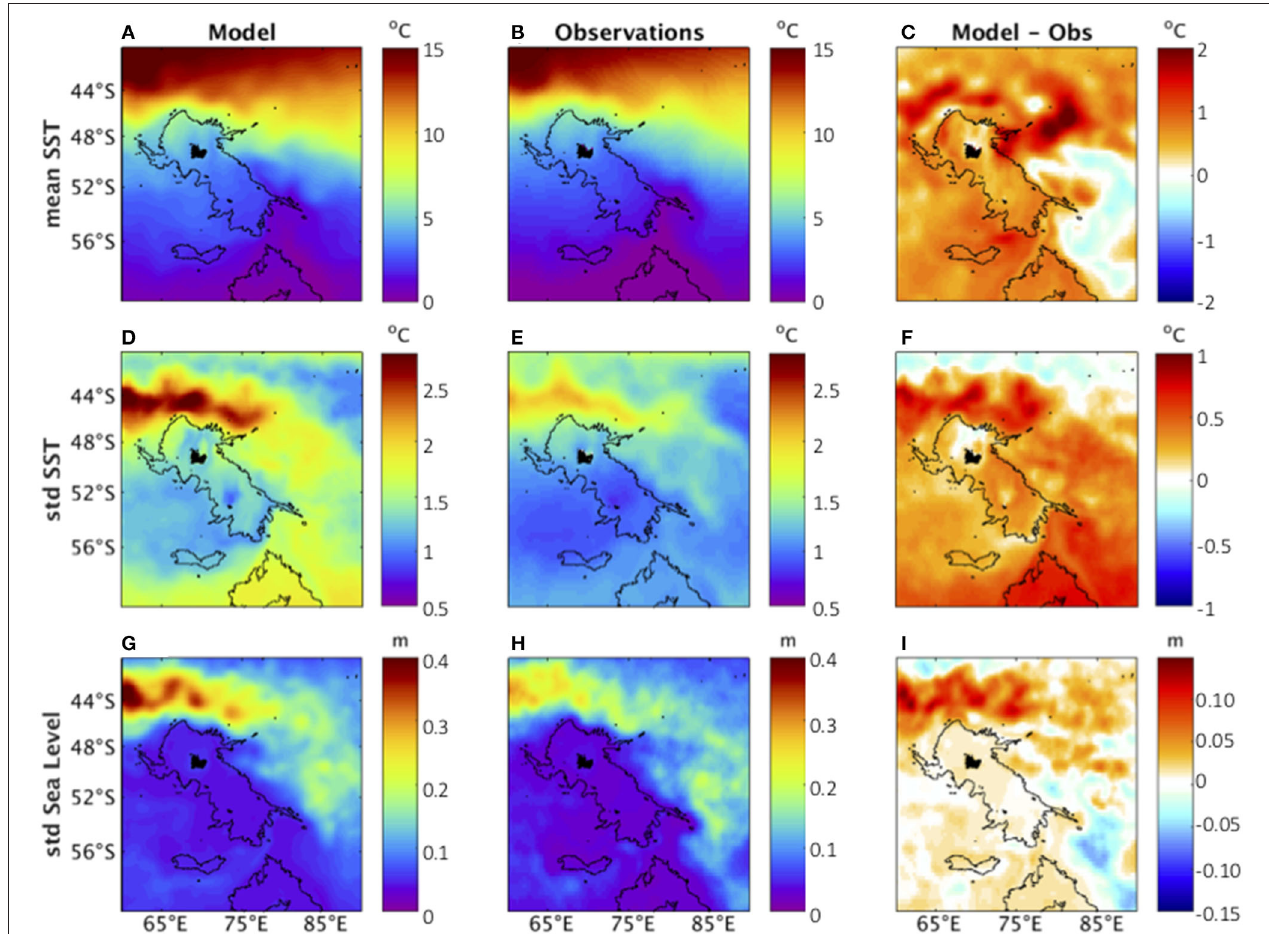
FIGURE 1 | Mean SST (1994–2016) in (A) OFAM, (B) NOAA-OI observation-based product, and (C) the difference between model and observations; (D–F) same as in (A–C) but for SST standard deviation; (G–I) same as in (A–C) but for sea level standard deviation in (G) OFAM and (H) AVISO satellite